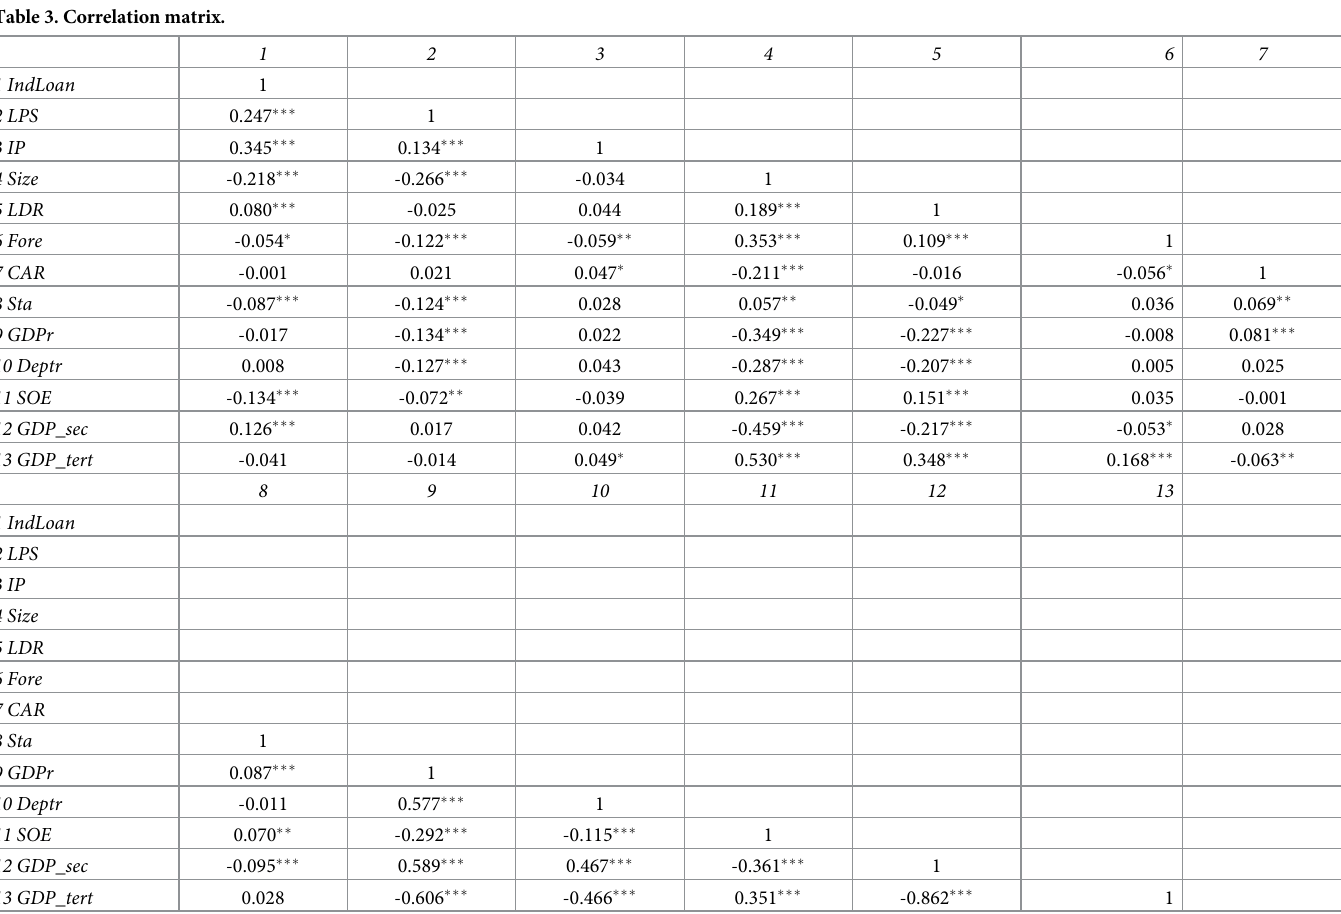
Table 3. Correlation